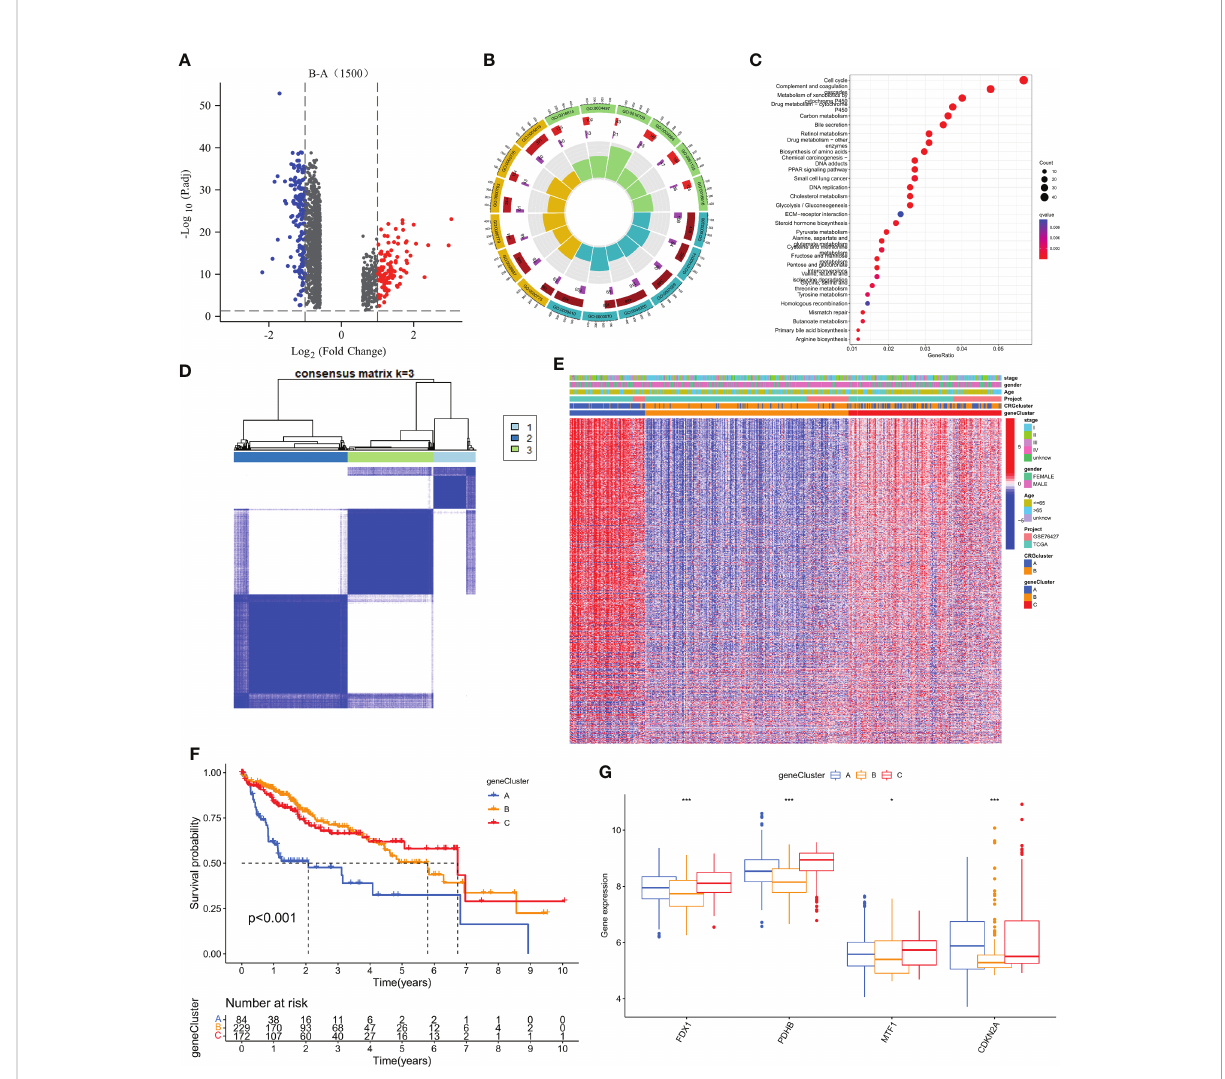
FIGURE 4 Identi fi cation of gene subtypes based on DEGs. (A) 1500 DEGs between different subtypes of volcano map. (B, C) GO and KEGG enrichment analyses of DEGs among two cuprotosis subtypes. (D) Consensus matrix heatmap de fi ning two clusters (k = 3) and their correlation area. (E) Relationships between clinicopathologic features and the three gene subtypes. (F) Kaplan – Meier curves for OS of the three gene subtypes (log- rank tests, p < 0.001). (G) Differences in the expression of 4 CRGs among the three gene subtypes. *P < 0.05, **P < 0.01, ***P <